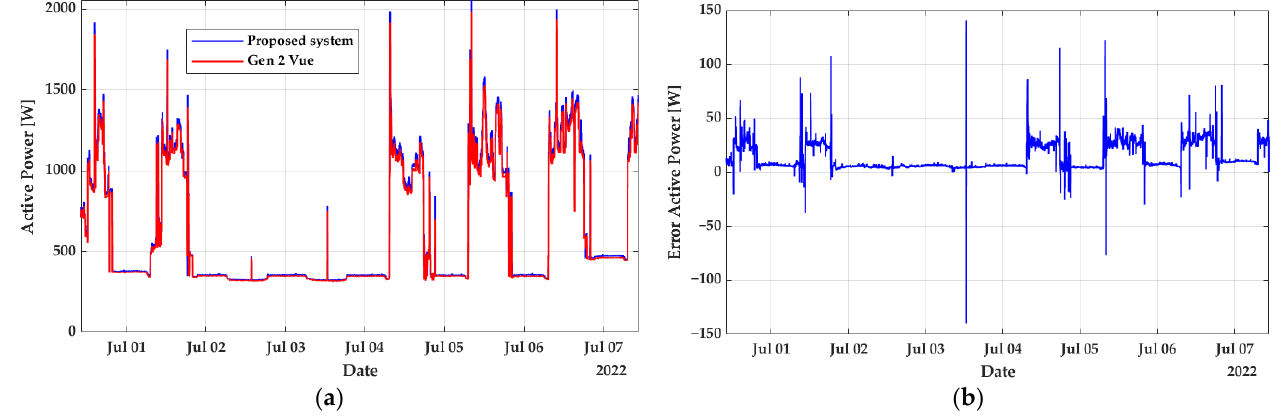
Figure 17. Active power in line 2: ( a ) comparison between the proposed system and the commercial monitor; ( b ) measurement errors of the proposed system with respect to the commercial monitor.